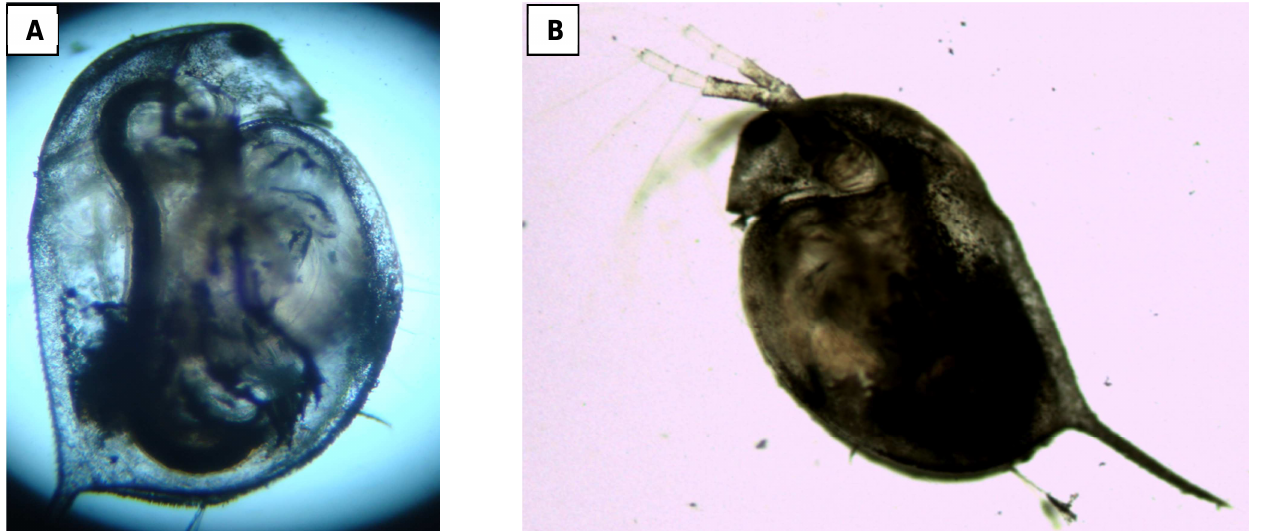
) particles by Daphnia magna 24 hours after 2 ) (100 mg/l) (Particles of nTiO 2 2 can be ingested by 2